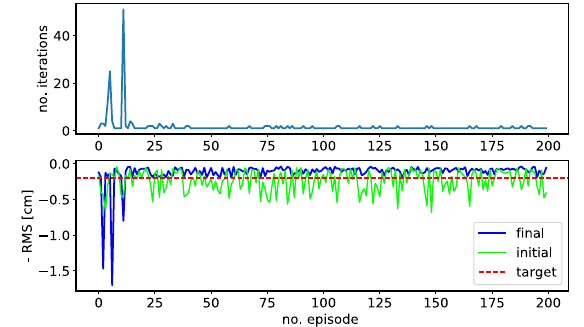
FIG. 6. Online training of NAF agent of AWAKE electron line trajectory steering in the horizontal plane. In the upper plot the number of iterations per episode is given. The lower plot shows the initial and final negative RMS value for each episode. The target negative RMS value is indicated in red.